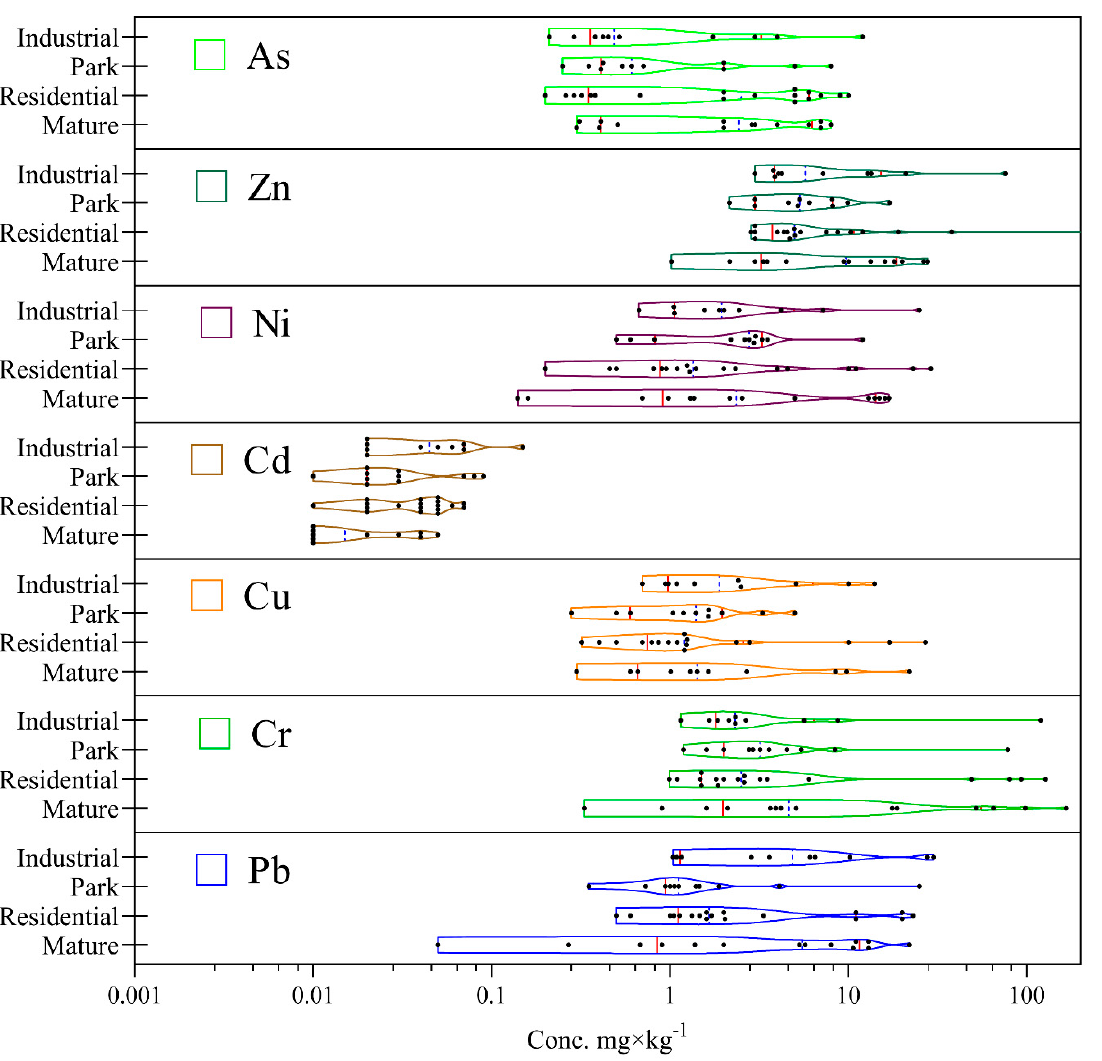
Figure 7. Variation of trace metals concentrations within functional zones. Table 3. Content of trace metals in pristine and anthropogenically loaded soils of the Yamal region, mg × kg − 1 .